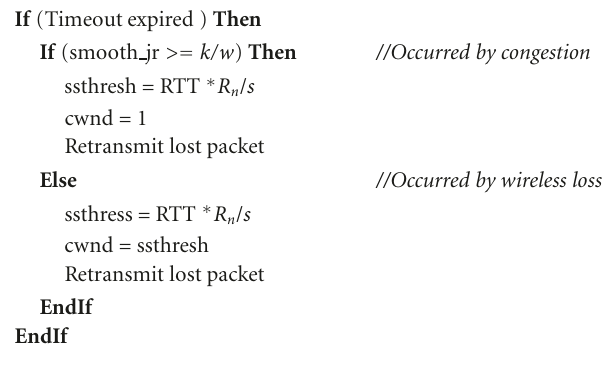
Algorithm 2: Pseudocode of JSCTP when timeout occurred.